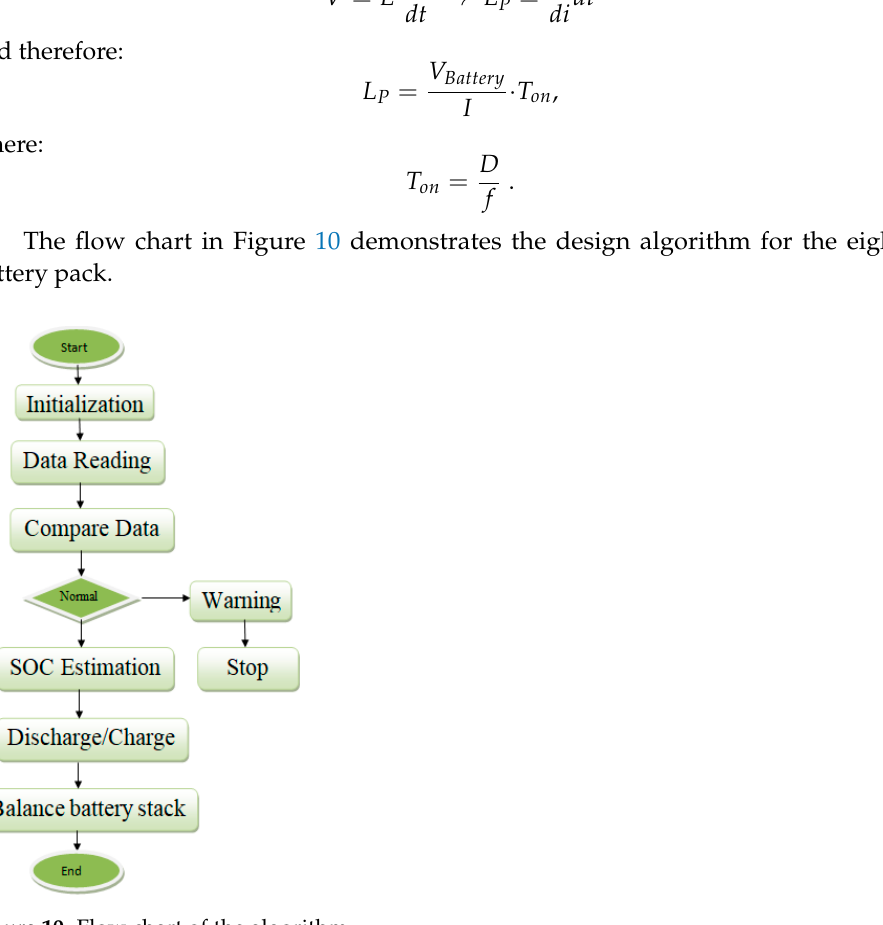
Figure 10. Flow chart of the algorithm .